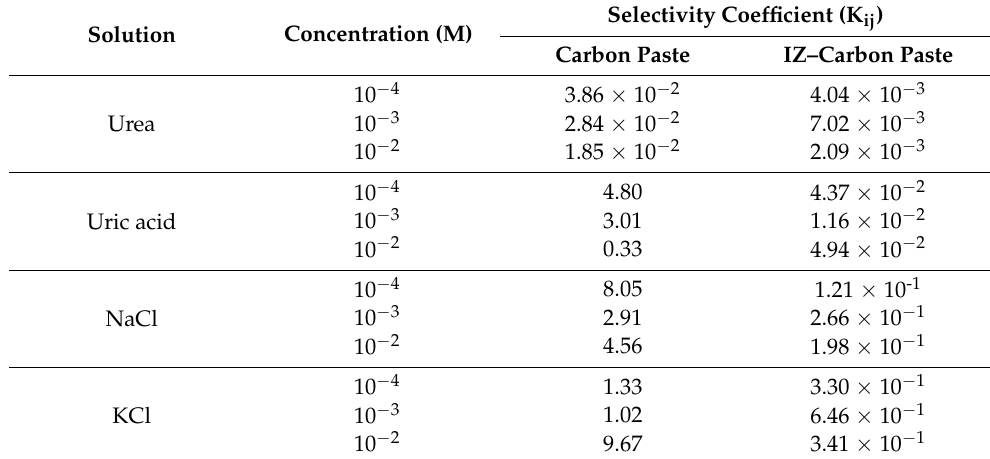
Table 8. Data on the K ij value of carbon paste and IZ–carbon paste electrodes. Solution